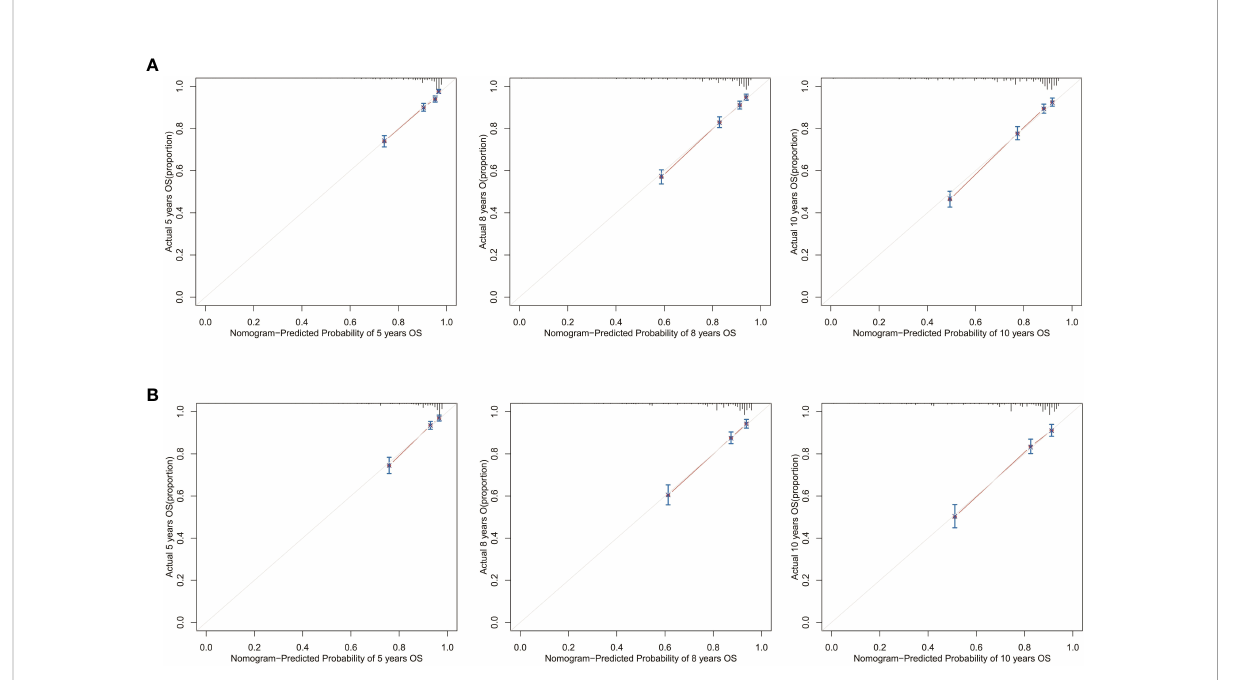
FIGURE 8 Calibration curves for the OS nomogram. 5-, 8-, and 10-year calibration curves for the OS nomogram in the (A) training cohort and (B) validation